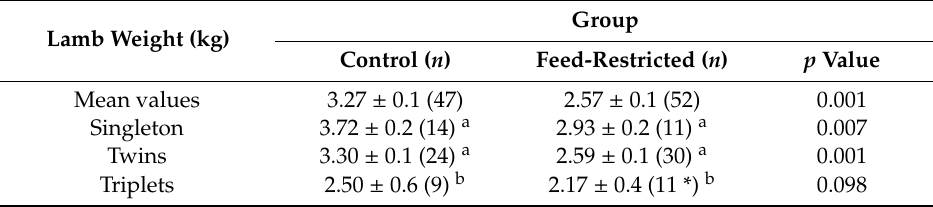
Table 3. Lamb body weight at parturition in feed-restricted and control ewes (mean ± SEM).